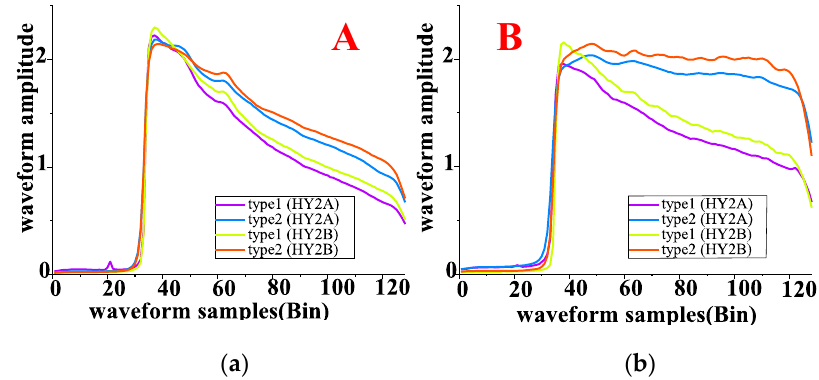
Figure 13. Average waveforms of the old ice with PP values less than 3 and the average waveforms of the seawater: ( a ) Average waveform of the Ku Band; ( b ) average waveform of the C Band. Note: Type 1 waveform was the echoes from the diffuse surfaces of the old ice; Type 2 waveform was the echoes from the diffuse surfaces of the seawater. Remote Sens. 2019 , 11 , x FOR PEER REVIEW